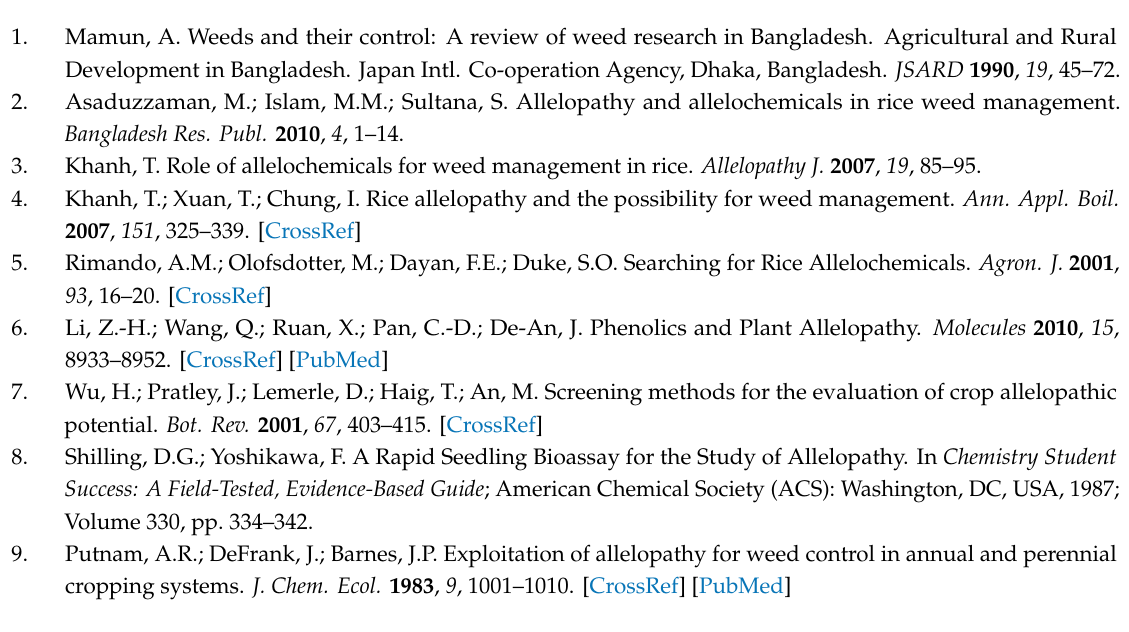
Table S1: The 785 SNP markers genotype for 98 RILs. Table S2: The candidate 31 genes located in the detected QTL region on chromosome 8. Figure S1: Linkage map for 12